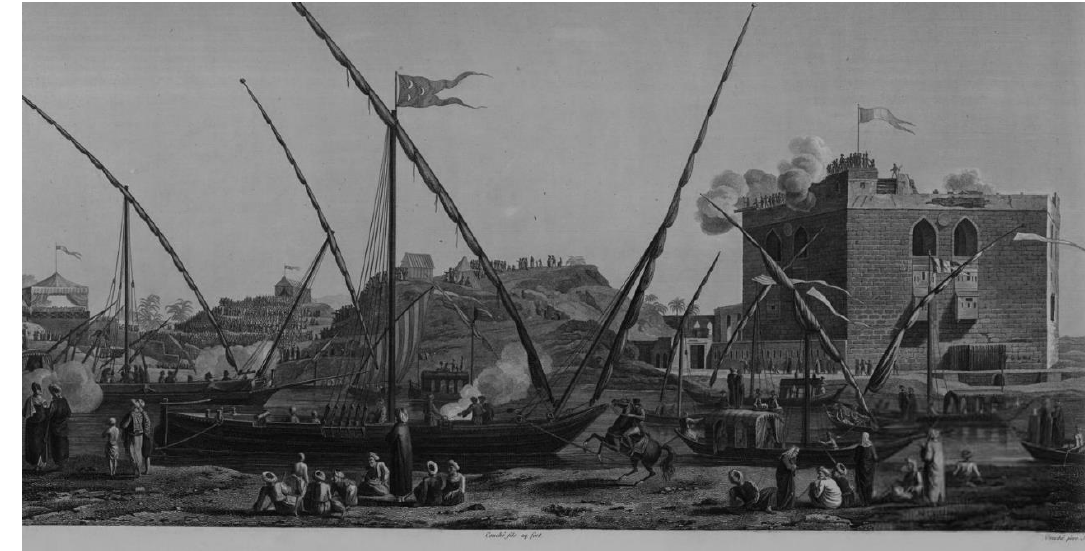
Figure 4: Cairo’s central canal (El-Khalig El-Massry) at its origin (Fom